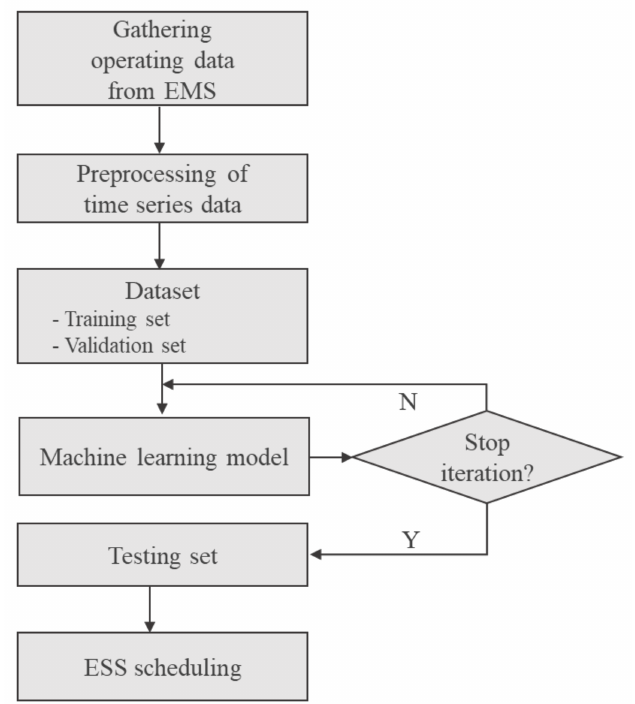
Figure 7. Flowchart of the proposed ESS optimal scheduling using machine learning.